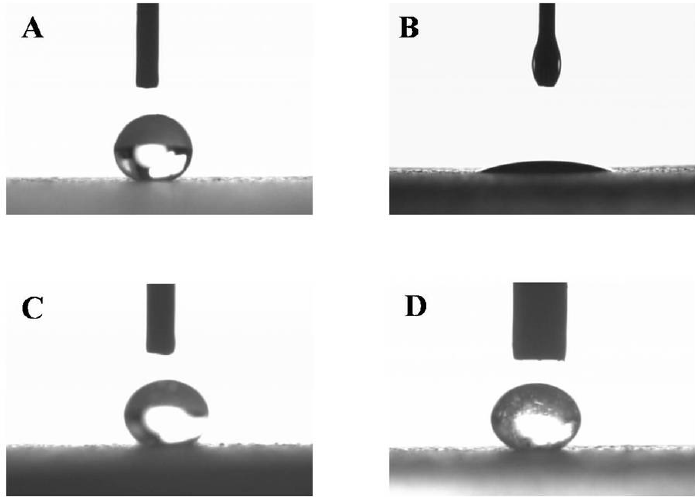
Figure 3. Images of contact angles for ( A ) water, ( B ) olive oil, ( C ) optimized VP-loaded Ch-based dispersion F8 and ( D ) optimized VP-loaded Ch/Kc-PEC-based dispersion F8/3.58. Table 3. Static contact angles (CA), sliding angles (SA) and percentage trapped air for the tested liquids on superhydrophobic treated glass surfaces compared to their CA on untreated glass surfaces. Untreated Surface System